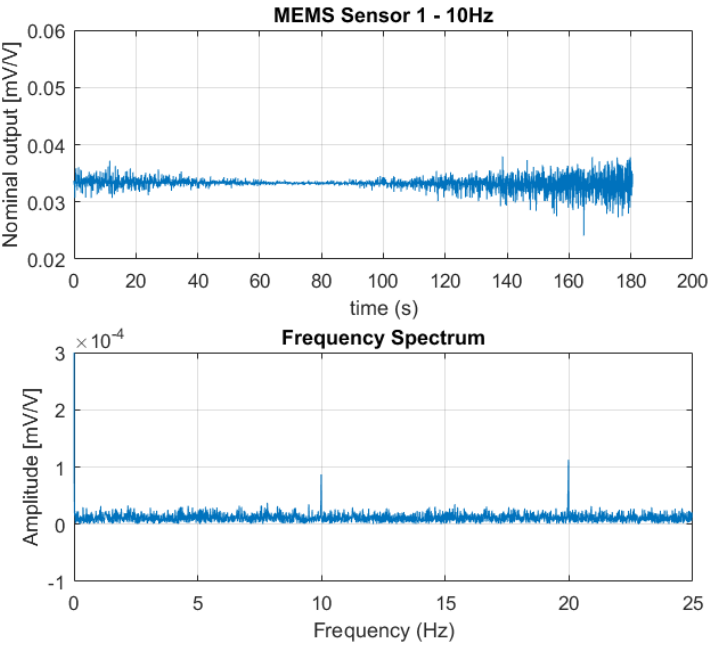
Figure 7. The output signal from one of the sensors in the MEMS-based sensor system as a response to the 10 Hz excitation vibration ( above ) together with the fast Fourier transform of the data set ( below ). The fast Fourier Transform clearly shows the fundamental excitation frequency at 10 Hz with an amplitude far above the noise floor; also, the second order harmonics at 20 Hz is visible.